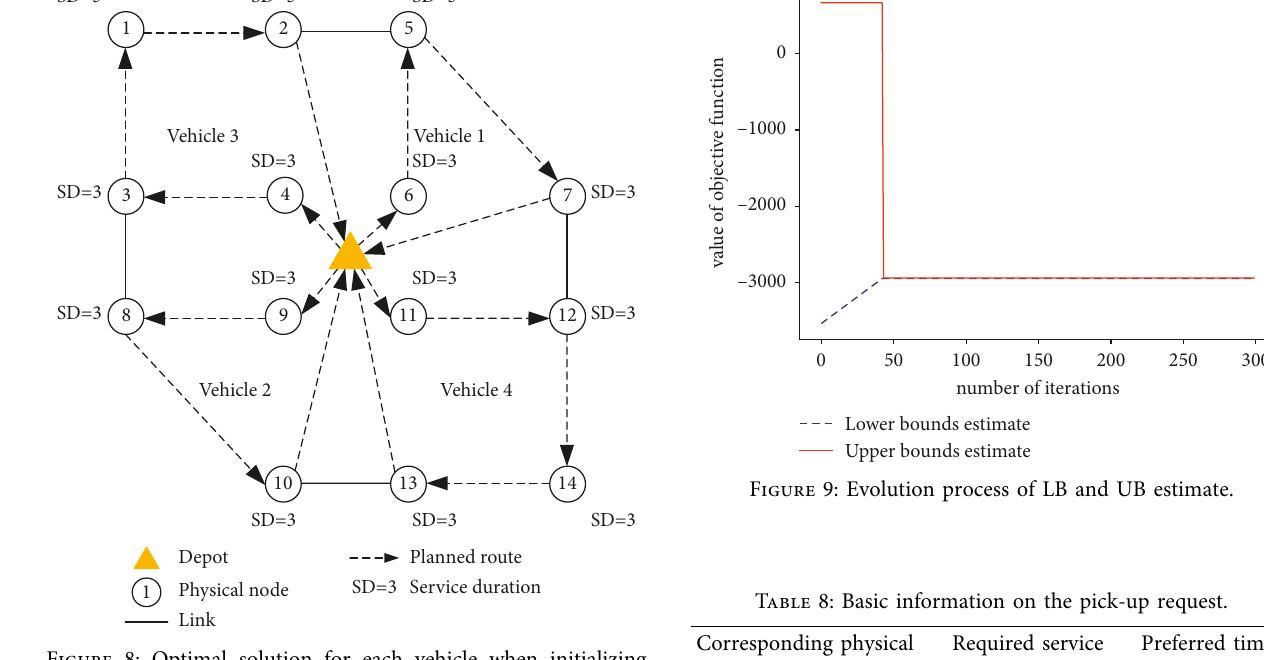
Figure 8: Optimal solution for each vehicle when initializing original routing plan ( τ � 0). Table 7: Optimal solution demonstration for initial routing plan. Vehicle